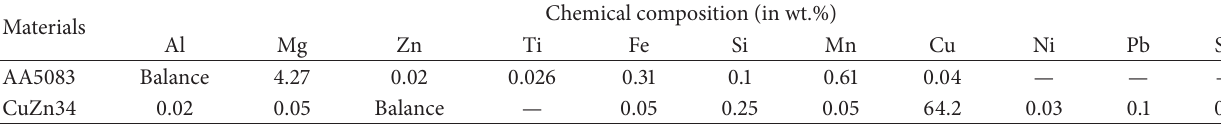
Table 1: Chemical composition and thickness of welded materials.